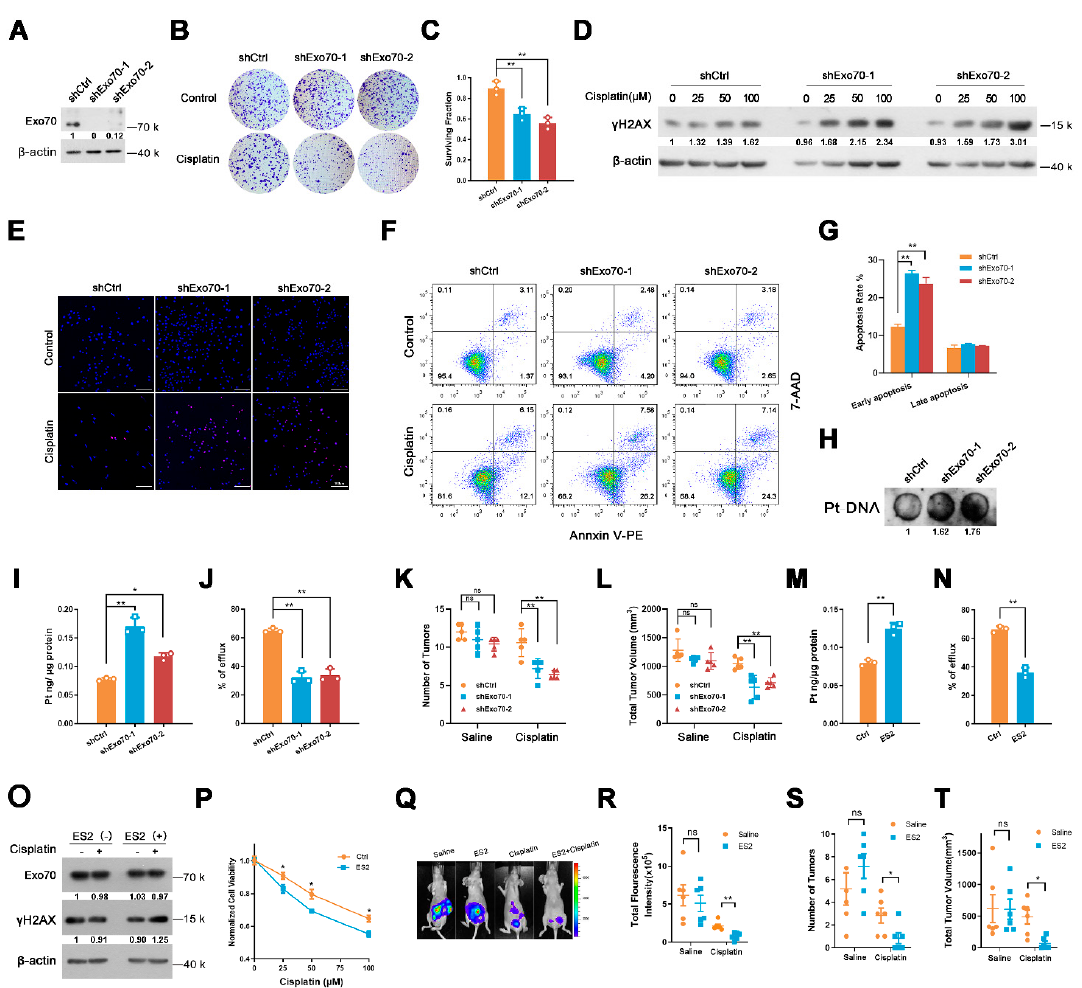
Figure 6. Exo70 silencing or inhibition of its activity reverses cisplatin resistance on A2780CR cells. ( A ) Western blotting showed the effects of Exo70 knockdown by shRNA in A2780CR cells. ( B ) Representative photos of the colony − formation assay showed the cytotoxicity of cisplatin on A2780CR cells. ( C ) Percentage of cells survived in colony formation assay. Data were expressed as mean ± SEM, n = 3. ** p < 0.01 ( D ) Western blotting showed γ H2AX expression in A2780CR cells with 100 µ M cisplatin treatment for 3 h. ( E ) Representative images of TUNEL assay showed the apoptotic cells after cisplatin treatment. Scale bar, 100 µ m. ( F ) Representative images of FACS analysis by Annexin V and 7 − AAD double staining. ( G ) Percentage of apoptotic cells as detected by FACS analysis. Data were expressed as mean ± SEM, n = 3. ** p < 0.01 ( H ) Dot − blot assay showed the cisplatin − DNA adduct in genomic DNA in A2780CR cells. ( I , J ) ICP-MS results showed the intracellular cisplatin accumulation ( I ) and extracellular percentage of cisplatin ( J ) in A2780CR cells. Data were expressed as mean ± SEM, n = 3. * p < 0.05, ** p < 0.01 ( K ) The number of tumors in mice with peritoneal tumor xenograft with or without cisplatin treatment. Data were expressed as mean ± SEM, n = 5. ** p < 0.01. ( L ) Total tumor volume in mice with peritoneal tumor xenograft with or without cisplatin treatment. Data were expressed as mean ± SEM, n = 5. ** p < 0.01 ( M , N ) ICP-MS was carried out to detect the intracellular cisplatin accumulation ( M ) and extracellular percentage of cisplatin ( N ) in A2780CR cells treated with or without ES2. Data were expressed as mean ± SEM, n = 3. ** p < 0.01. ( O ) Western blotting showed γ H2AX expression in A2780CR cells with 100 μ M cisplatin together with ES2. ( P ) CCK8 assay accessed the cytotoxicity of cisplatin with or without ES2 treatment. Data were expressed as mean ± SEM, n = 4. * p < 0.05. ( Q ) Bioluminescent imaging of the nude mice bearing A2780CR tumors. ( R ) Quantitative analysis of tumors by measurement of luminescence in nude mice bearing A2780CR tumors. Data were expressed as mean ± SEM, n = 6. ns: not significant, ** p < 0.01. ( S ) The number of tumors in mice bearing A2780CR tumors. Data were expressed as mean ± SEM, n = 5. * p < 0.05. ( T ) Total tumor volume in mice bearing A2780CR tumors. Data were expressed as mean ± SEM, n = 5. * p < 0.05.